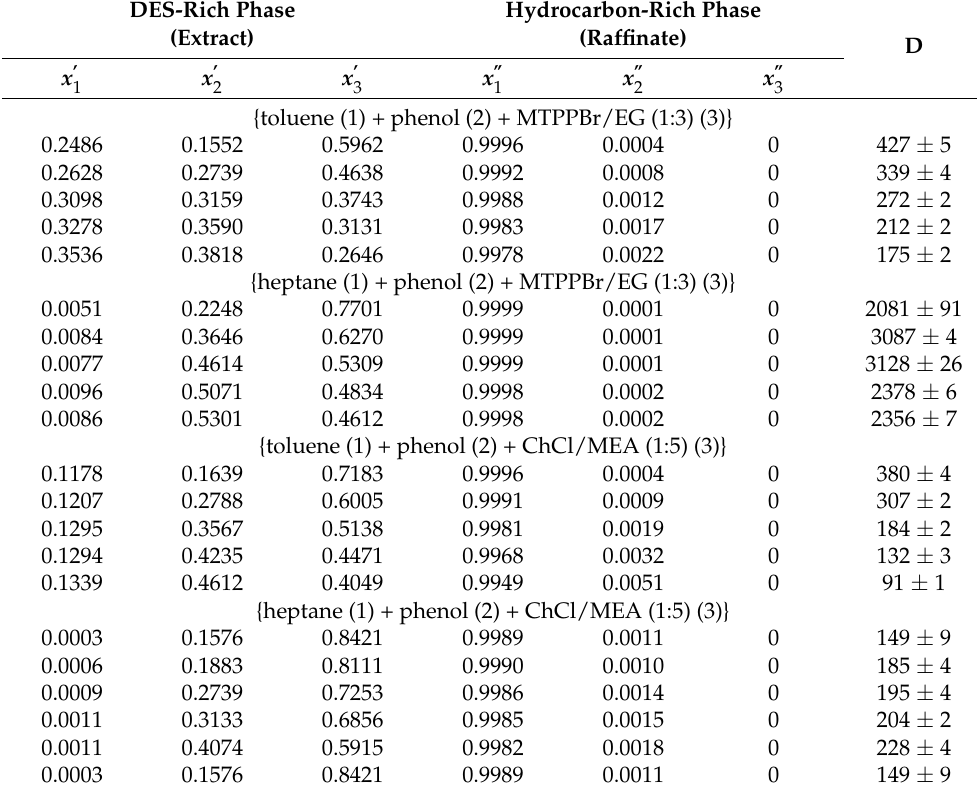
Table 4. Ternary LLE data for systems {toluene or heptane (1) + phenol (2) + MTPPBr/EG (1:3) (3)} and {toluene or heptane (1) + phenol (2) + ChCl/MEA (1:5) (3)} at 298.15 K and 101 kPa, as well as distribution ratio, D of DESs towards